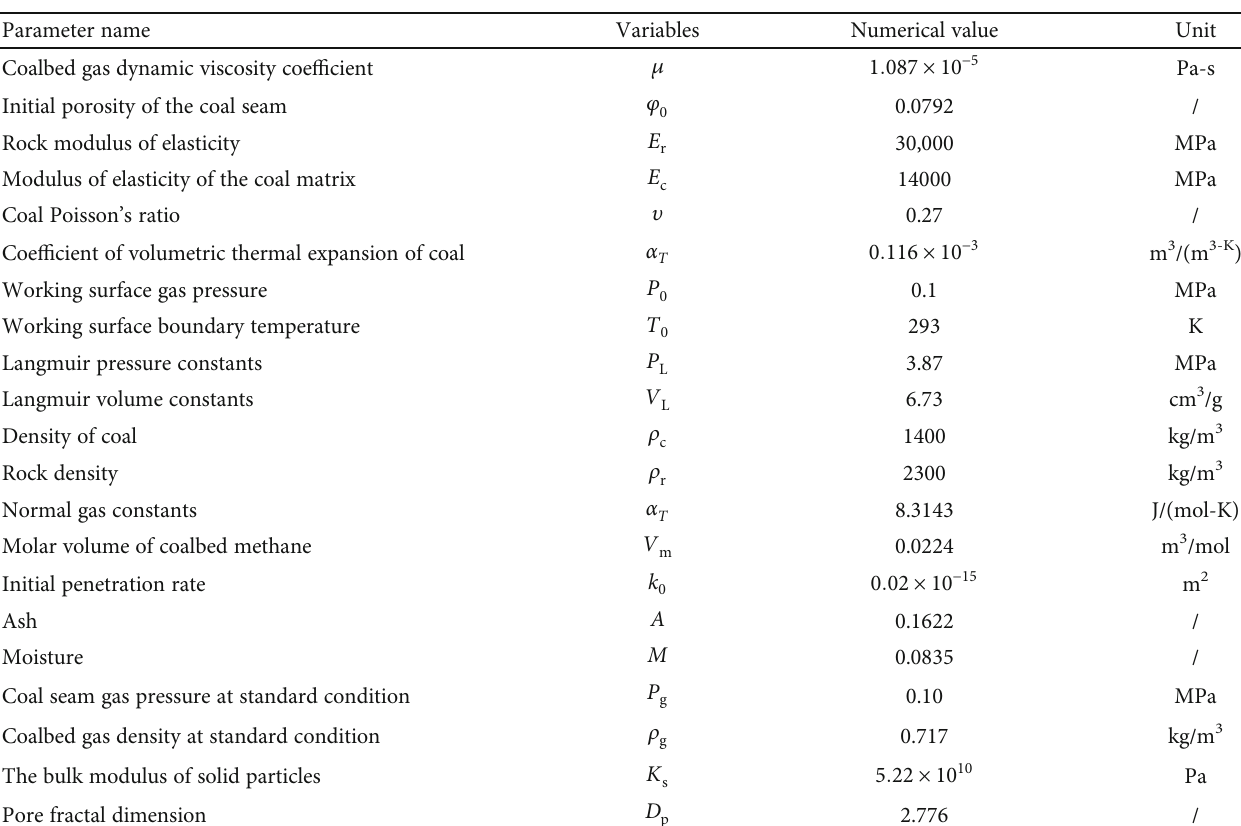
Table 4: Main parameters of 1302 coal mining face